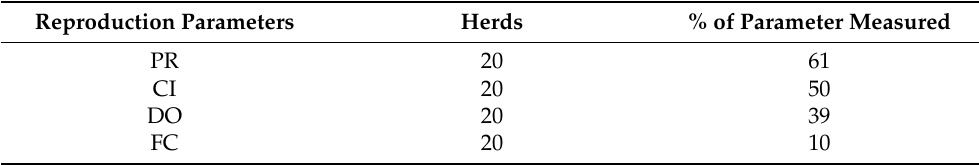
Table 4. Summary of reproductive performance of smallholder beef cows at provincial level.